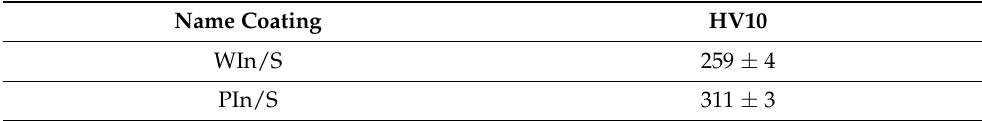
Table 2. Vickers hardness of Inconel 625 coatings onto the S235JR substrate.